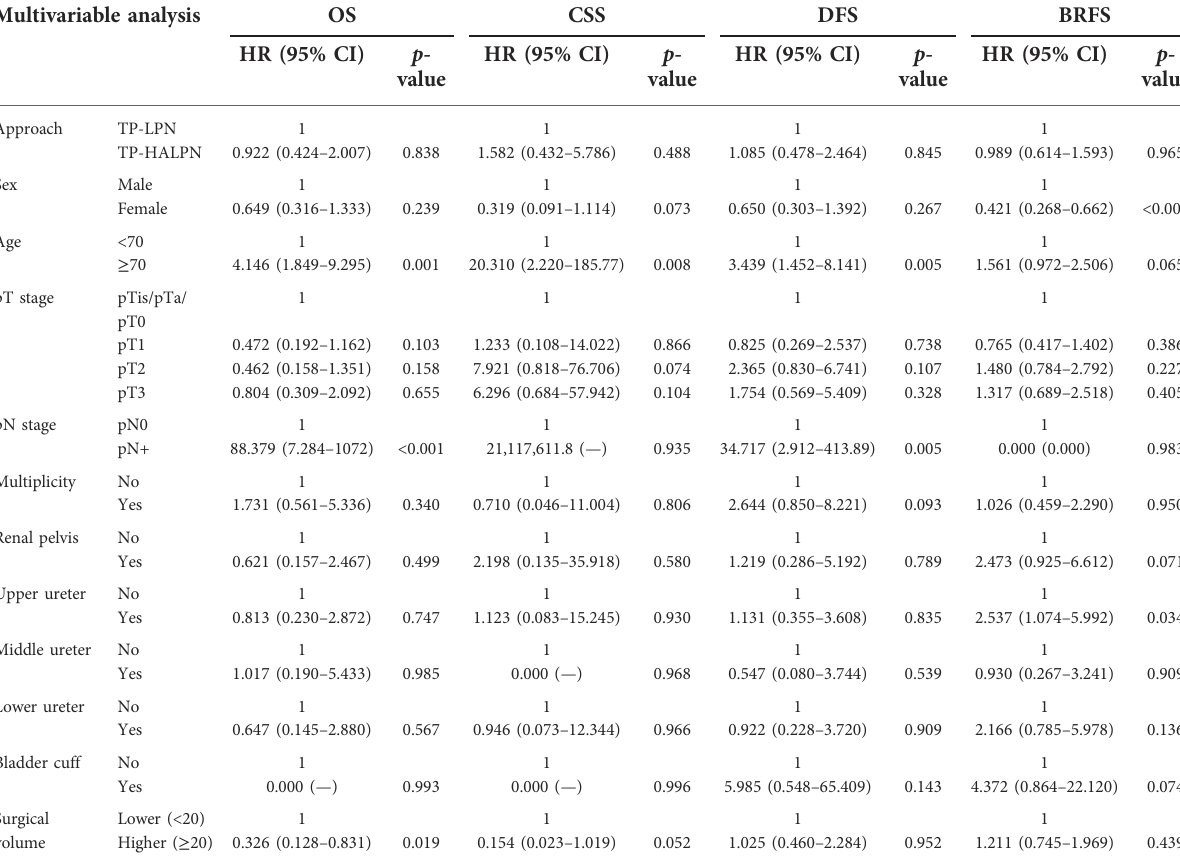
TABLE 4 Comparative multivariable survival analysis of UTUC patients. Multivariable